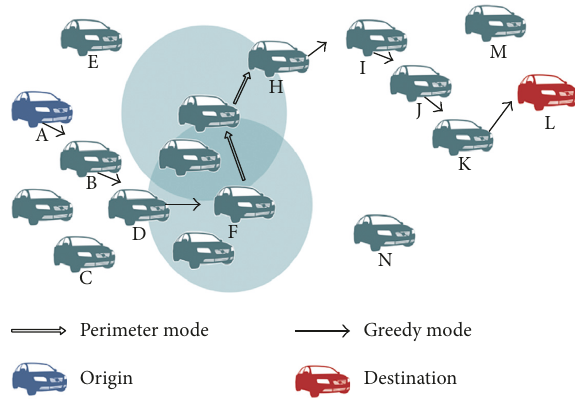
Figure 4: Proceeding of the GPSR